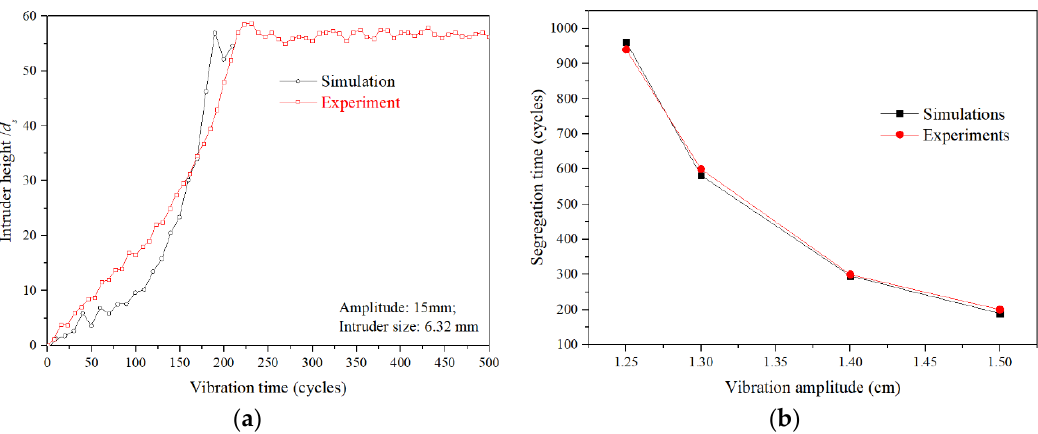
Figure 2. Comparison of simulation results and experiment results in Nahmad-Molinari et al. [11]: ( a ) the ascending height of the intruder as a function of vibration time; ( b ) the segregation time as a function of vibration amplitude under f = 7.5 Hz.